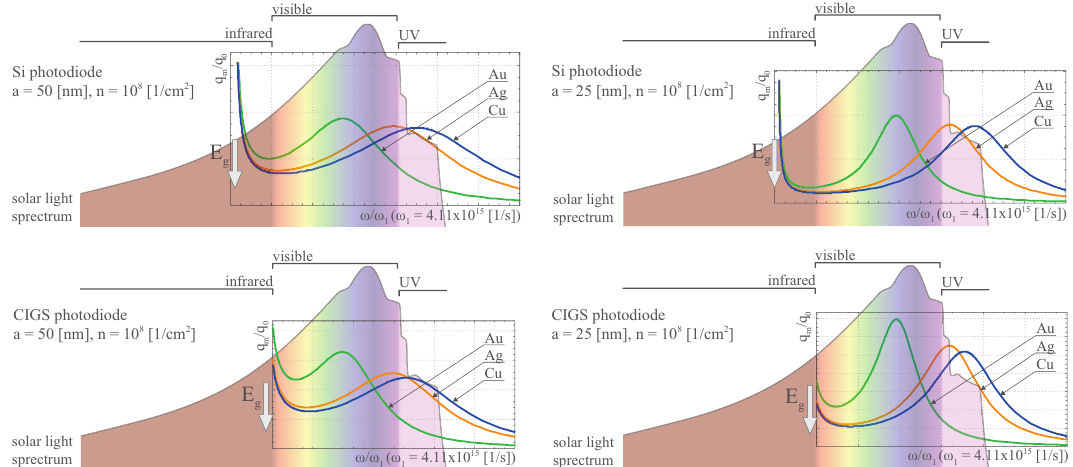
( ω ) (cf. q 0 ( ω ) , to sun-light q 0